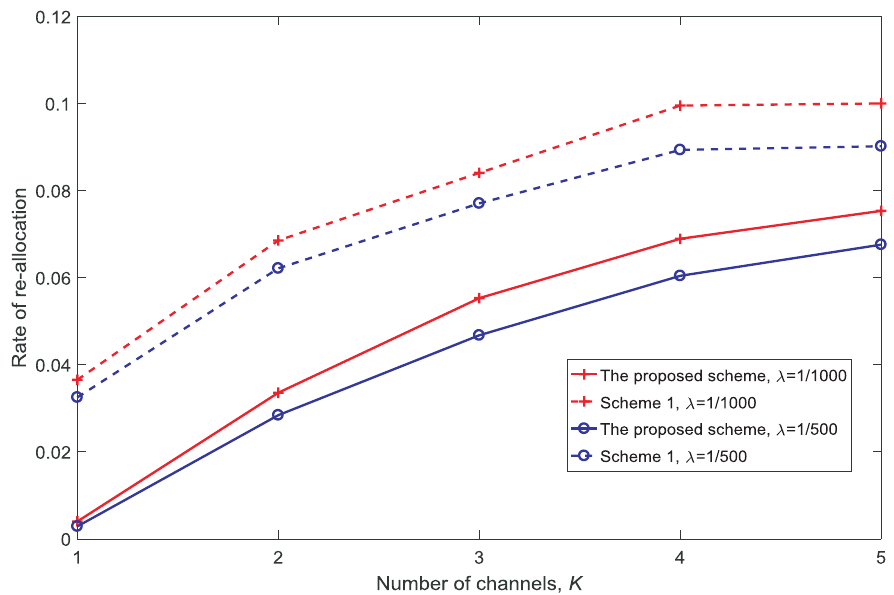
Figure 10. Rate of re-allocation for different numbers of channels K ( d V = 10, V = 10, N = 5 ) .